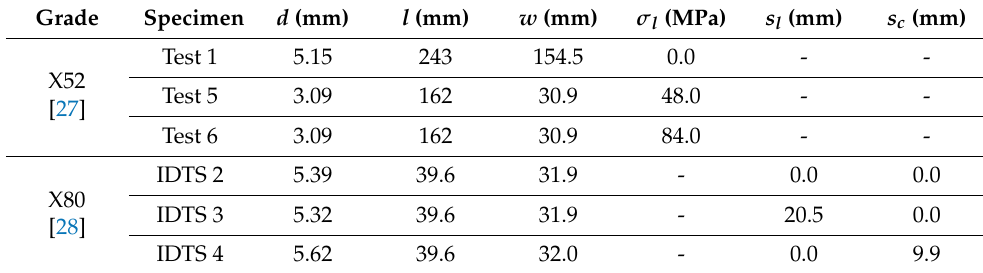
Figure 3. Illustration of the region of failure depicted by the red contour. Table 6. Summary of burst test details by Bjorney et al. and Benjamin et al.